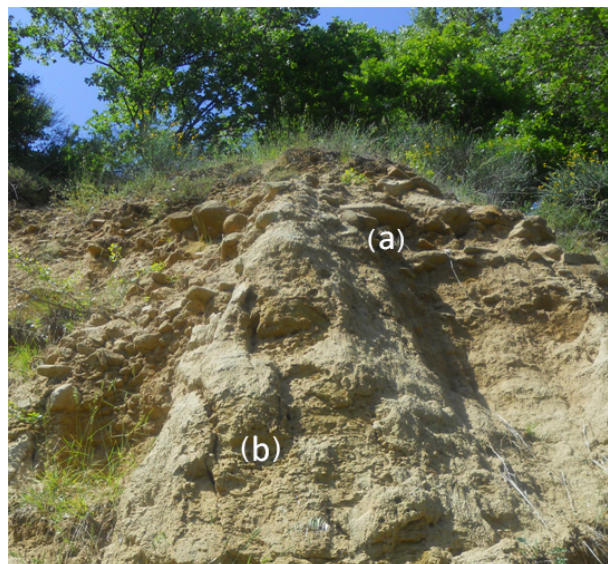
Figure 8. Representative outcrop of the Torrente Casale alloforma- tion. Clast-supported massive conglomerates (a) upon sandy gravels and gravelly sands (b)